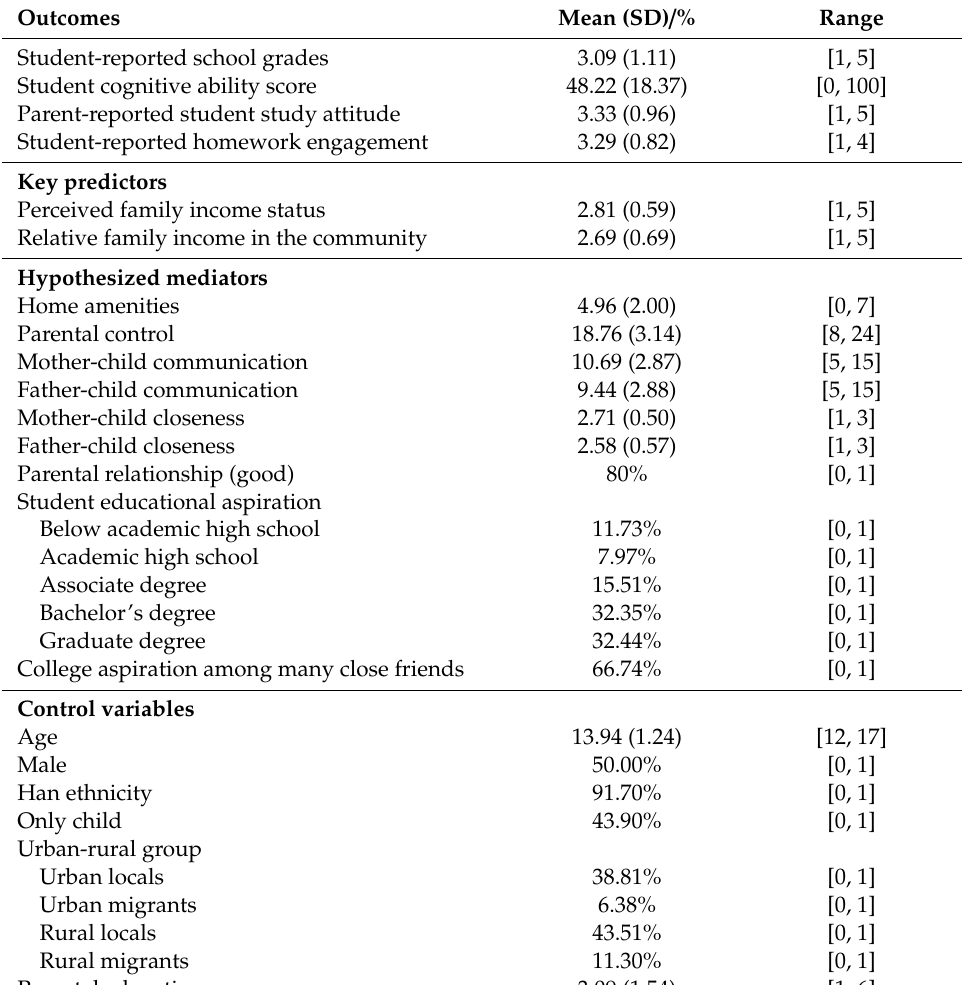
Table 1. Sample Descriptive